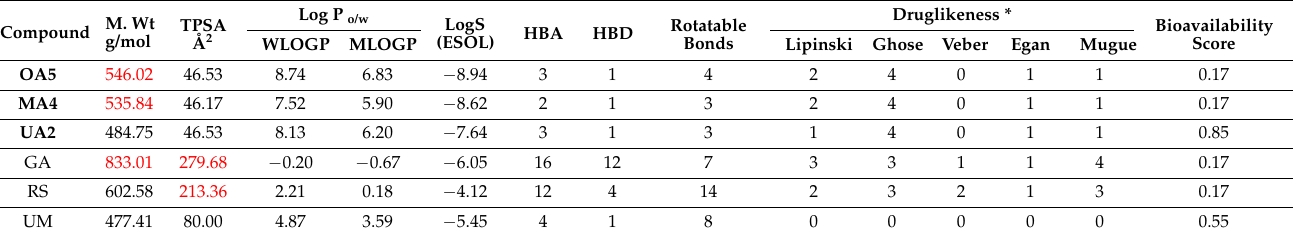
Table 2. Structural and physicochemical properties of the top selected derivatives and the reference molecules.